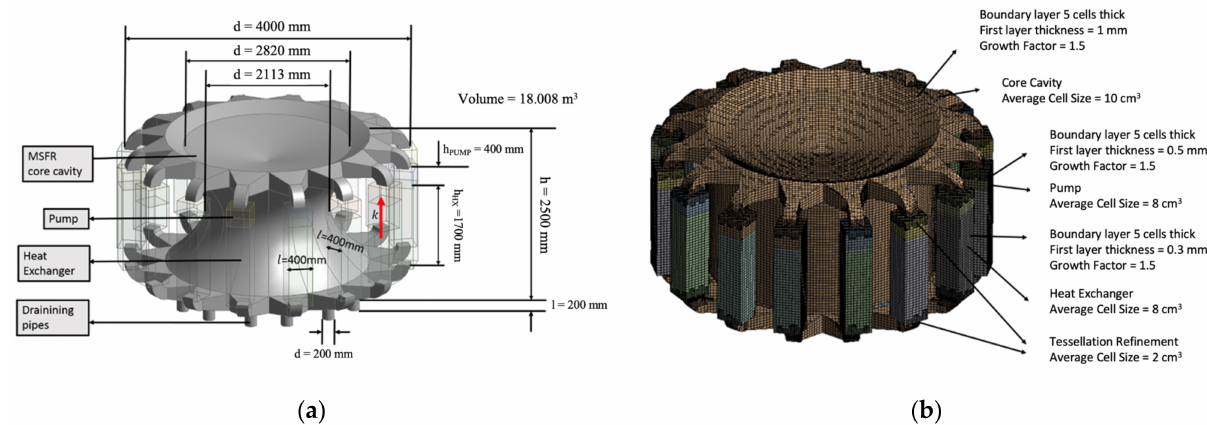
Figure 10. Setup of the MSFR simulations ( a ) Computational domain; ( b ) Computational